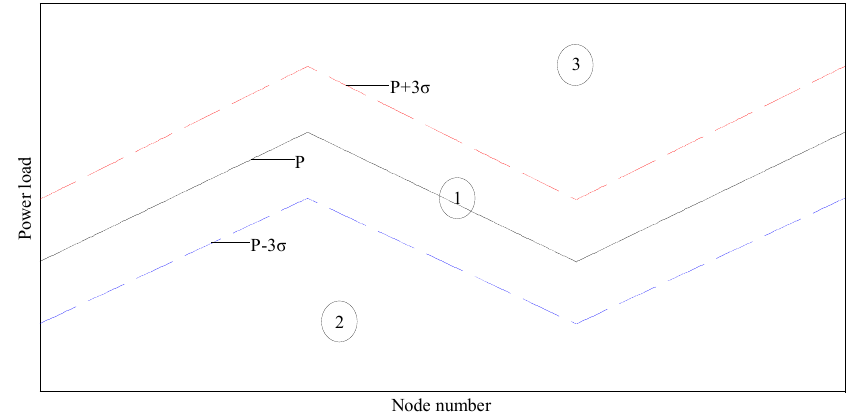
Figure 2. Schematic diagram of load distribution matching.